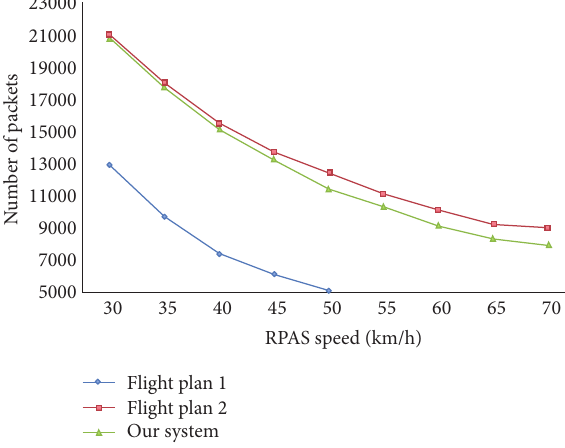
Figure 9: Transmission window